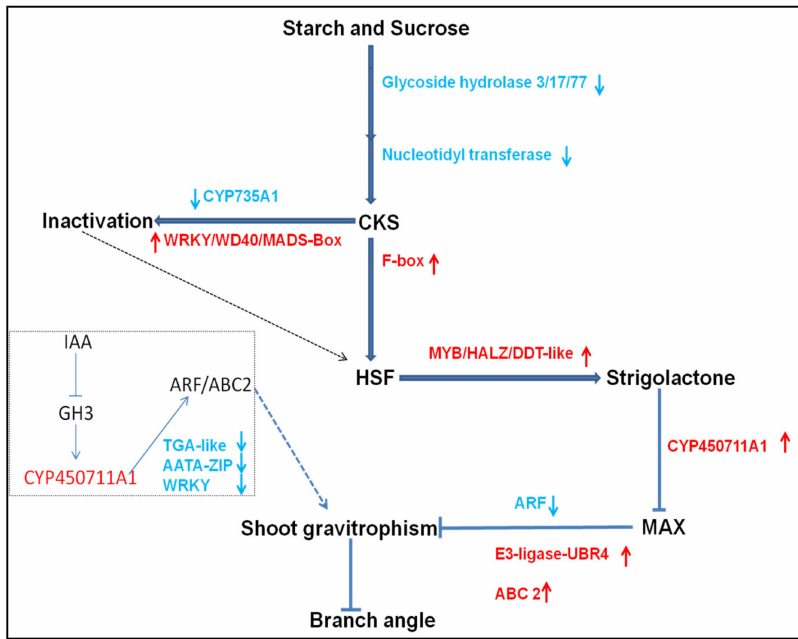
Figure 9. The proposed regulatory network underlying branch angle formation in peanut. Blue ar- rows demonstrate positive regulation. Red arrows indicate repression. Dotted blue lines demonstrate indirect positive regulation. The inverted blue arrows indicate the inhibition of gravitropic growth. Gravistimulation was affected by starch and sucrose metabolism and regulation of CKs (cytokinins), SLs (Strigolactones) and auxin signaling pathways which may act synergistically in the downstream regulatory pathway of shoot gravitropism in peanut.